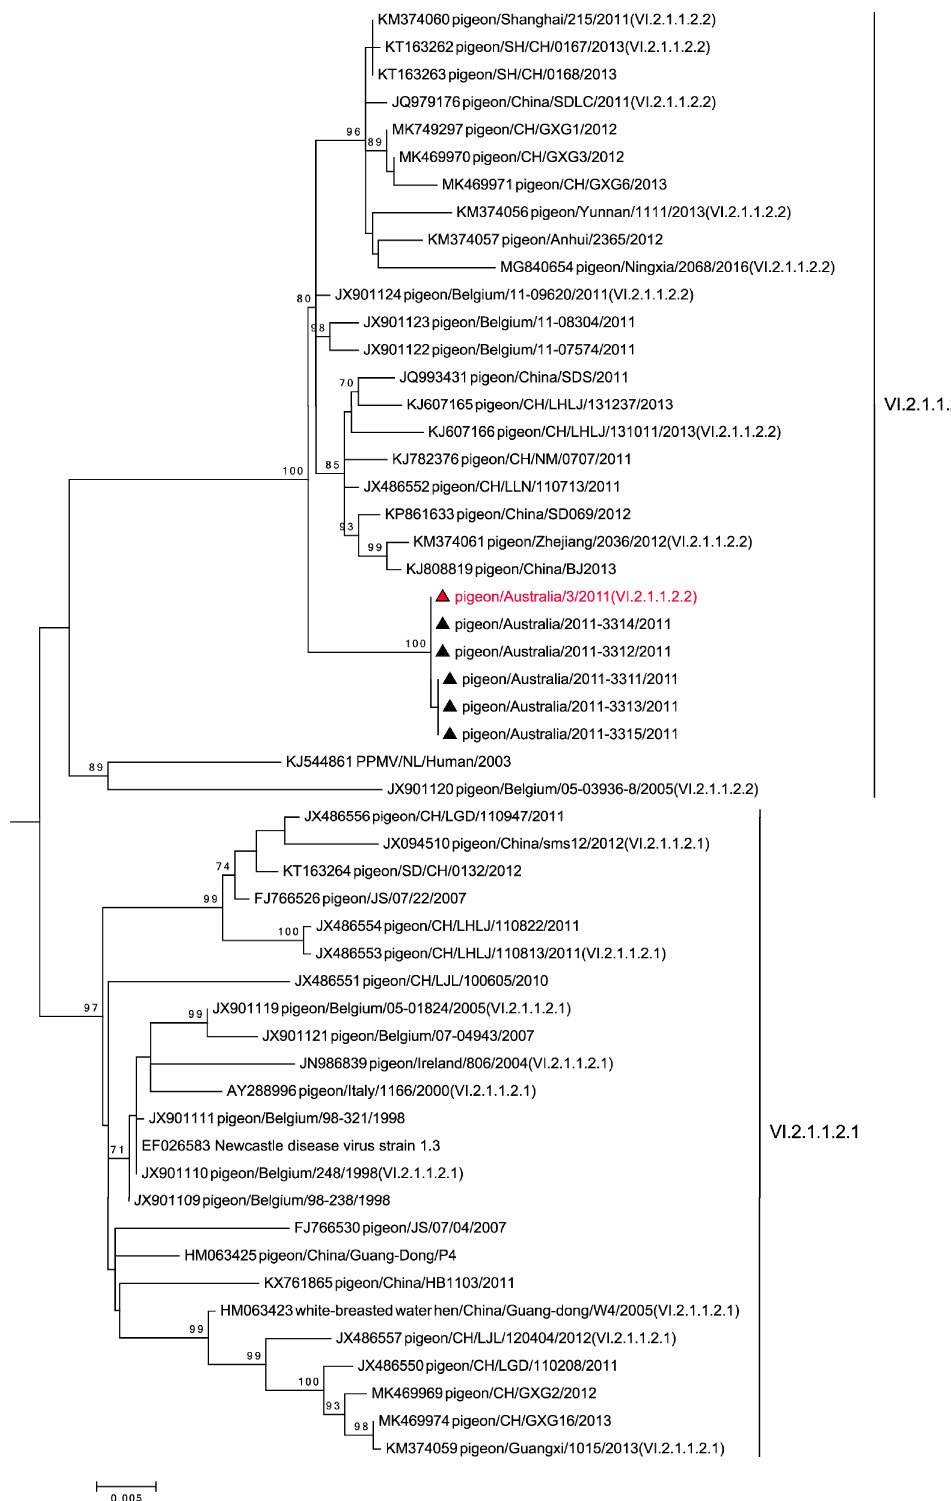
Figure 2. Maximum Likelihood (ML) tree based on the virus fusion protein gene showing genotype VI 2.1.1.2.2 (extracted from Supp. Figure S1 and denoted by vertical lines to the right of tree) with the 2011 Australian PPMV-1 virus samples (denoted by ▲ ) belonging in genotype VI.2.1.1.2.2. The P/Aus/3/11 isolate is indicated in red. Phylogenetic relationships were inferred using the ML method based on the General Time Reversible model [30]. Horizontal scale bar indicates the number of substitutions per site.